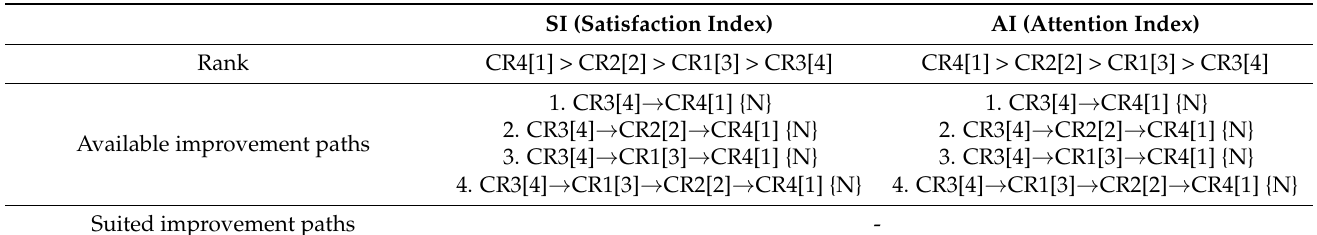
Table 14. The suited improvement paths of the communication and relationship (CR) aspect.